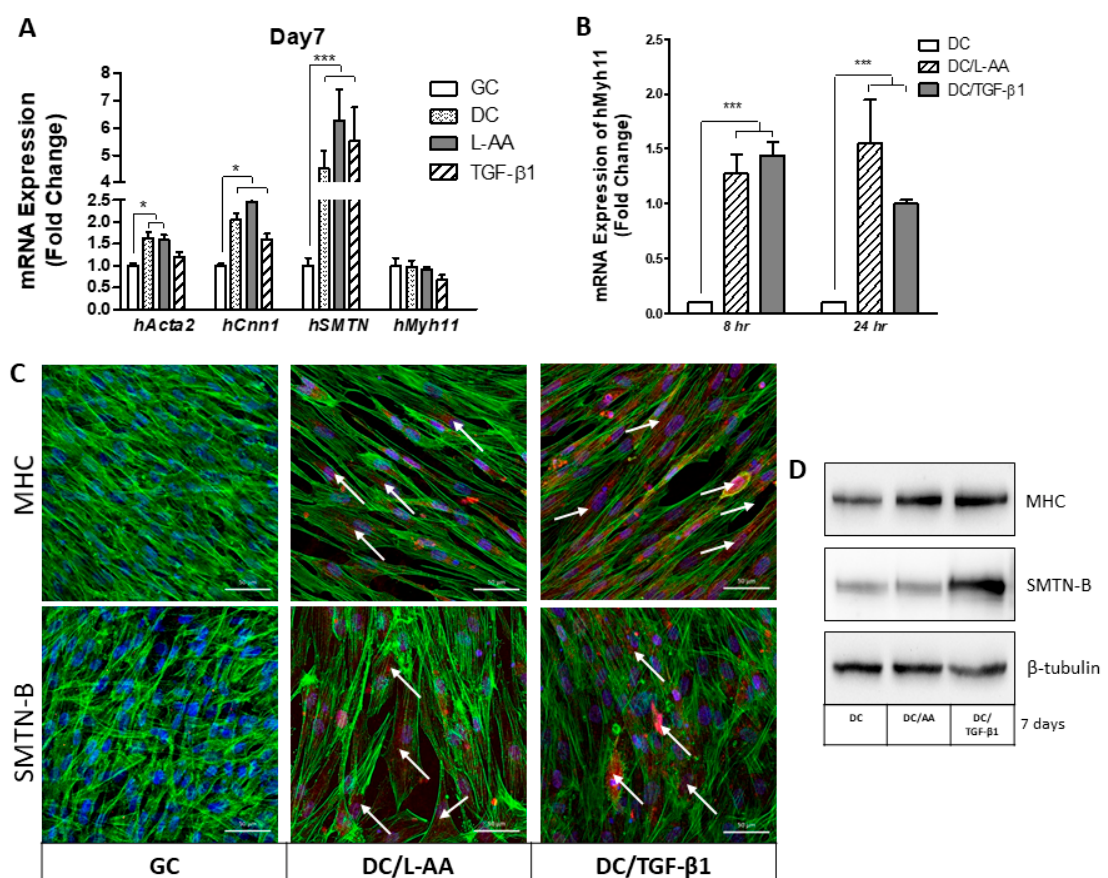
Figure 5. Differentiation potential of iMSCs towards vascular smooth muscle lineage in conventional 2-D cultures. ( A ) iMSC mRNA expression of hActa2 , hCnn1 , hSMTN , and hMyh11 was analyzed using Quantitative real-time polymerase chain reaction (qRT-PCR) after cell treatment with L-AA and TGF- β 1 for 7 days. GC stands for regular growth condition of iMSCs, and DC stands for differentiation inducible condition by exchanging culture media to DMEM with 1% FBS. ( B ) mRNA expression of hMyh11 by iMSCs after 8 h and 24 h of cultivation under DC. ( C ) iMSCs were cultured on coverslips, under differential conditions, for 7 days, MHC and SMTN-B were detectable with either AA or TGF- β 1 pre-treatment. Green channel is F-actin, and Red is MHC/SMTN-B. Nuclei are labeled by DAPI in Blue. Scale bar = 50 µm. ( D ) Western blot analysis revealed that vascular smooth muscle contractile marker SMTN-B was up-regulated by pre-treatment with TGF- β 1, whereas MHC was slightly up-regulated by either L-AA or TGF- β 1 pre-treatment. * p < 0.05; *** p < 0.001.